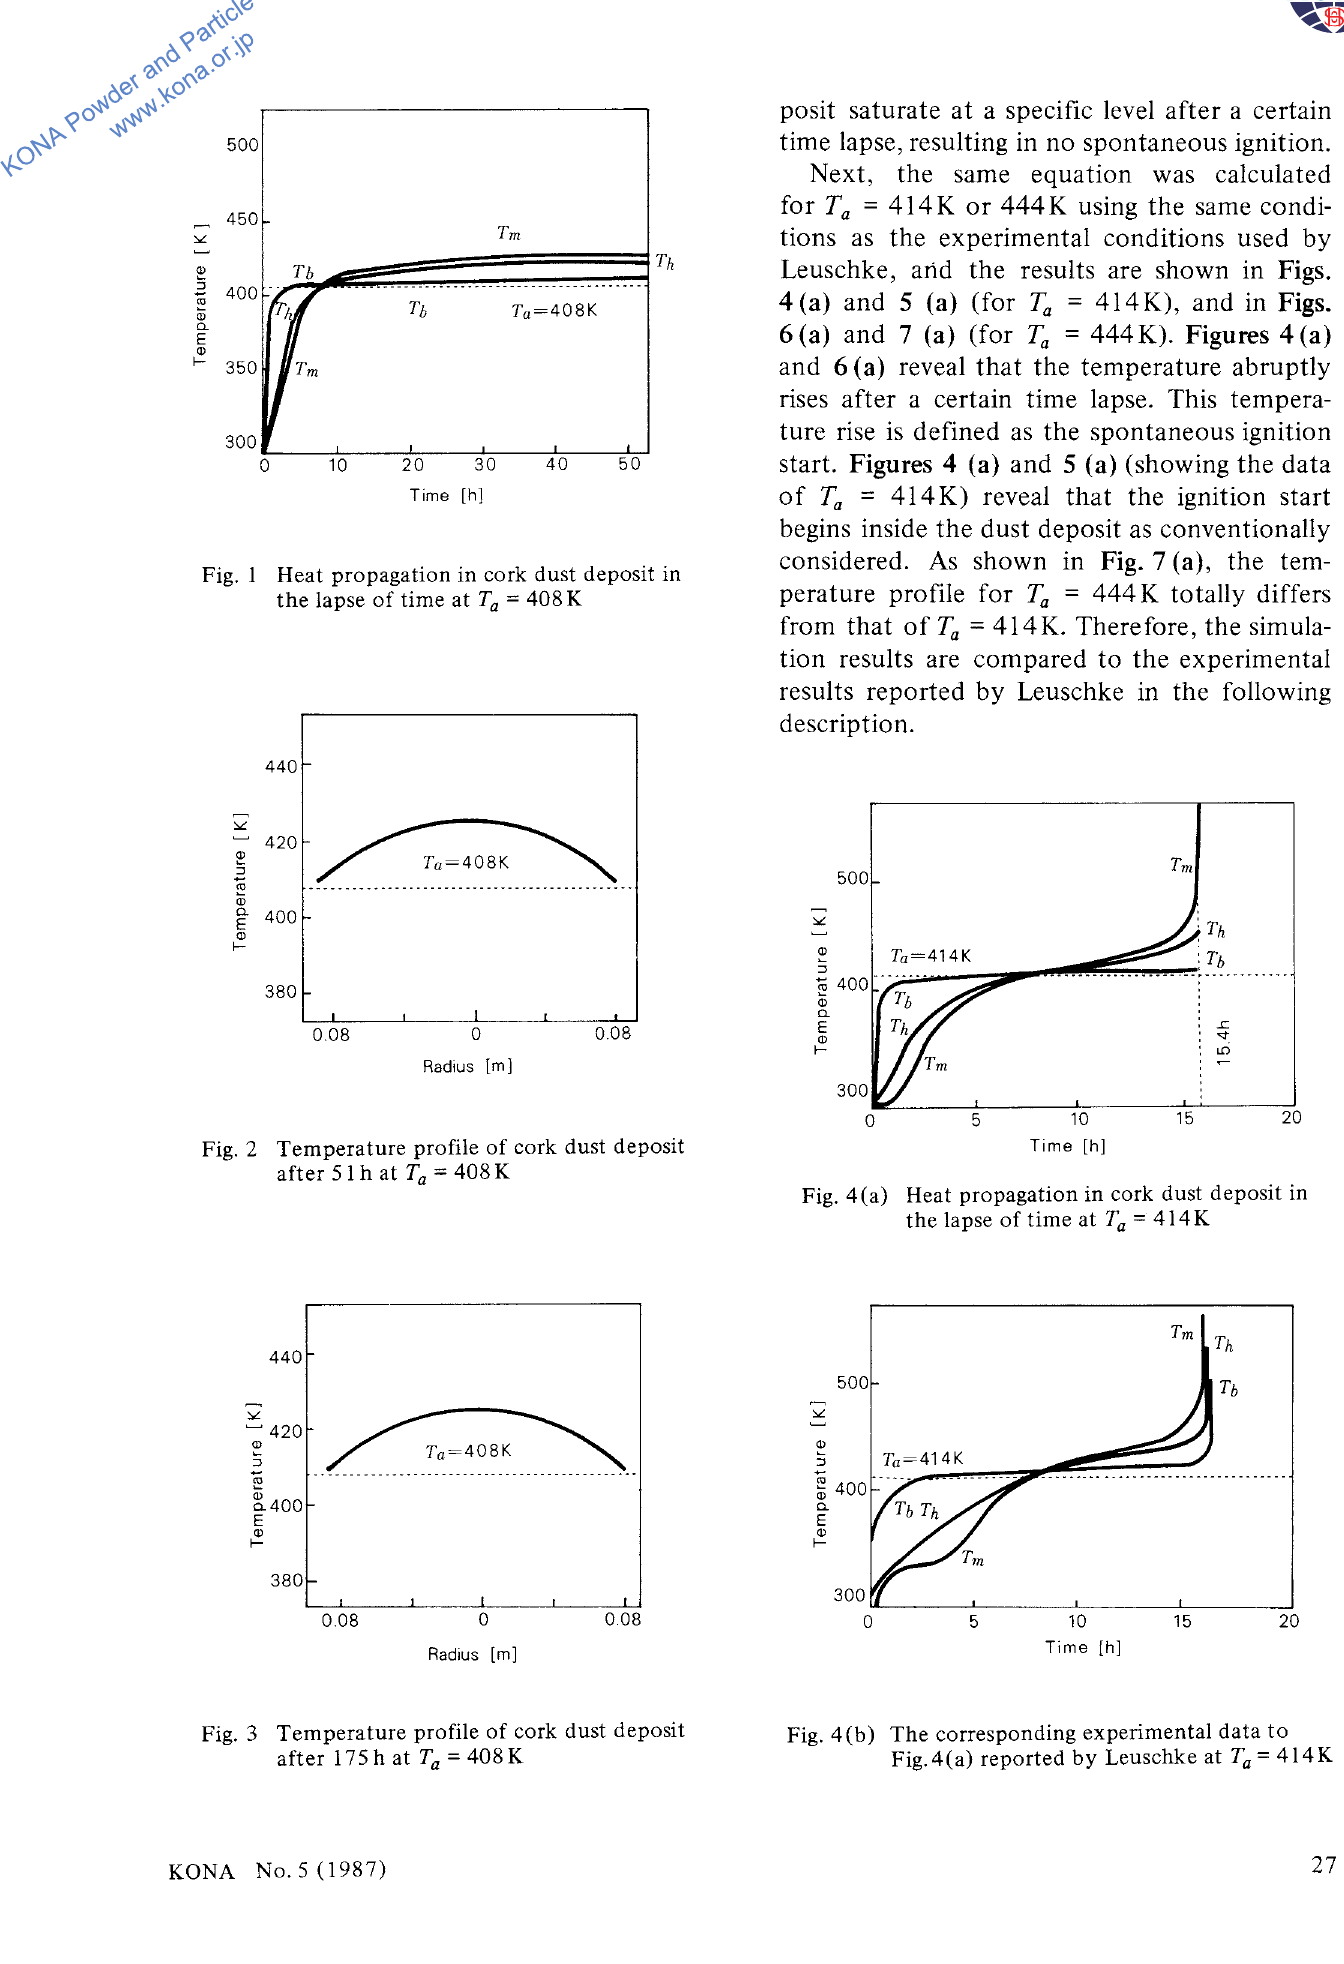
Fig. 3 Temperature profile of cork dust deposit after 175 hat Ta = 408 K